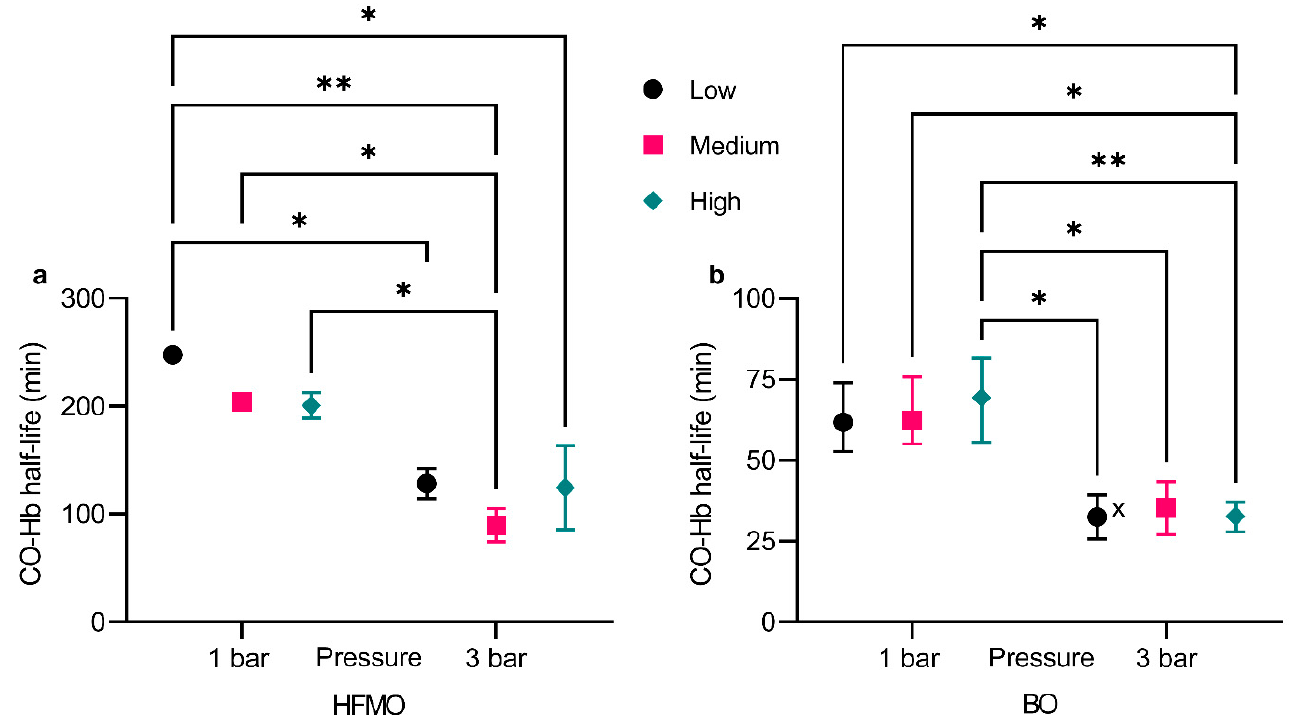
Figure 4. CO-Hb half-life with ( a ) HFMO and ( b ) BO dependent on pressure and flow rate. The whiskers represent the highest and lowest values of the corresponding experiments. Flow rate stands for blood flow rate for HFMO experiments and for gas flow rate for BO experiments. Note the different scale of the axes. (*) p ≤ 0.05, (**) p ≤ 0.01. (x) During one experiment, bubbles inside the samples prevented the analysis.